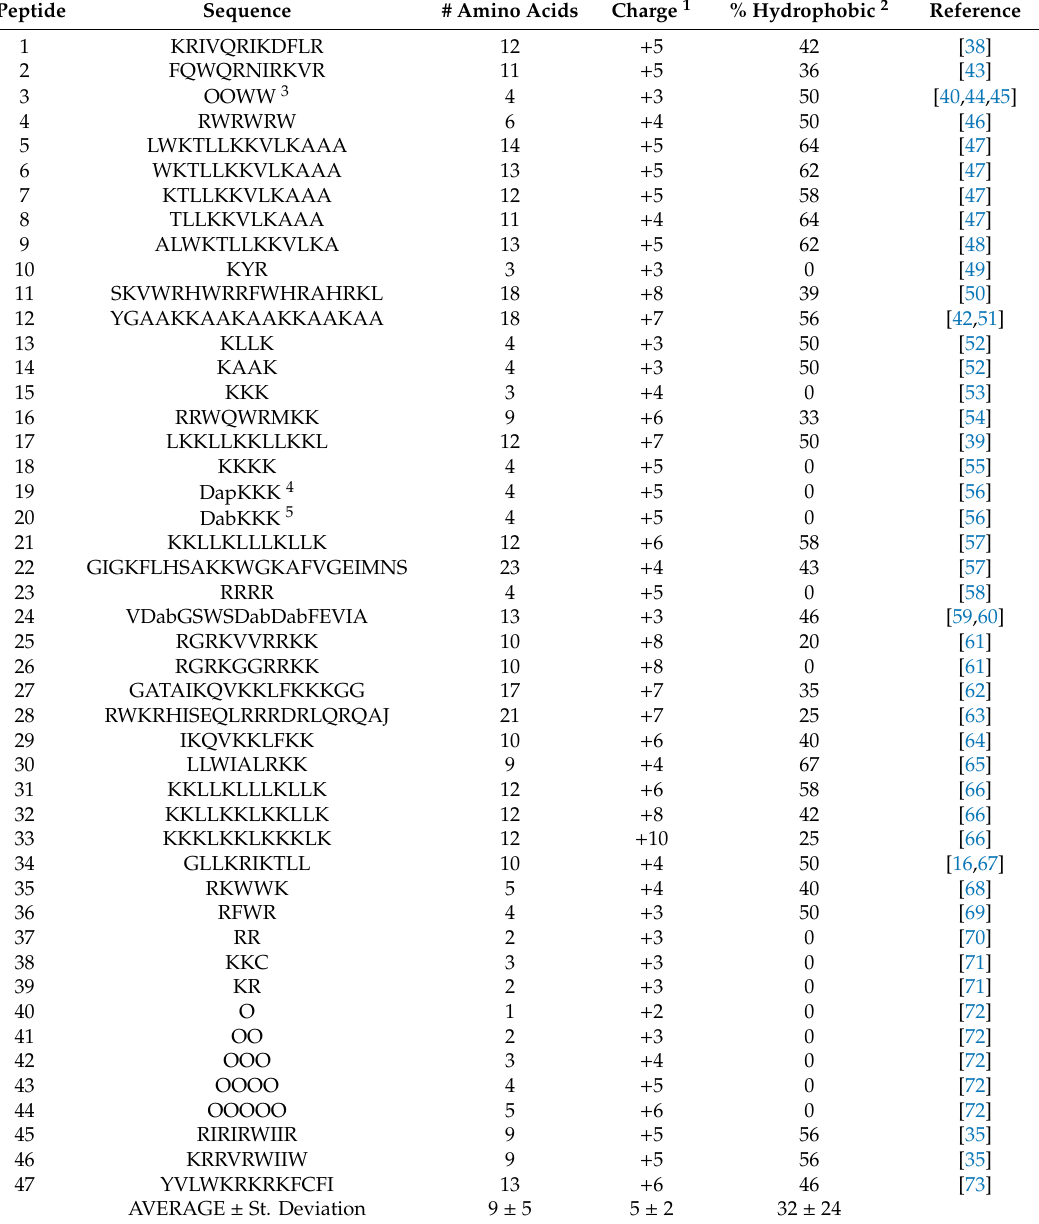
Table 1. List of host-defense peptides (HDPs) and some of their properties used to generate the plots in Figure